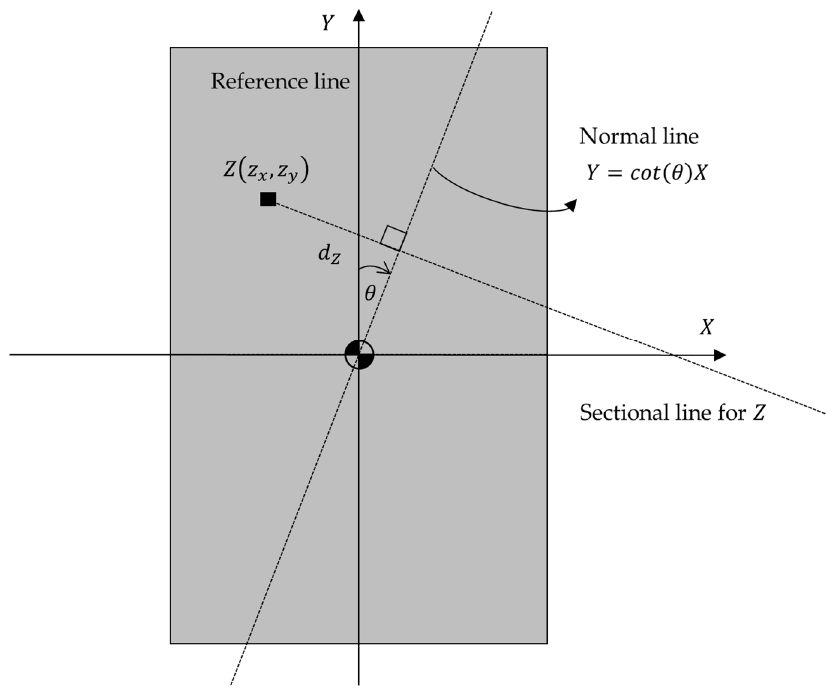
Figure 2. Geometrical figuration of the distance ( d Z ) of measurement point Z in the UCBC structure with carbon fiber orientation θ .